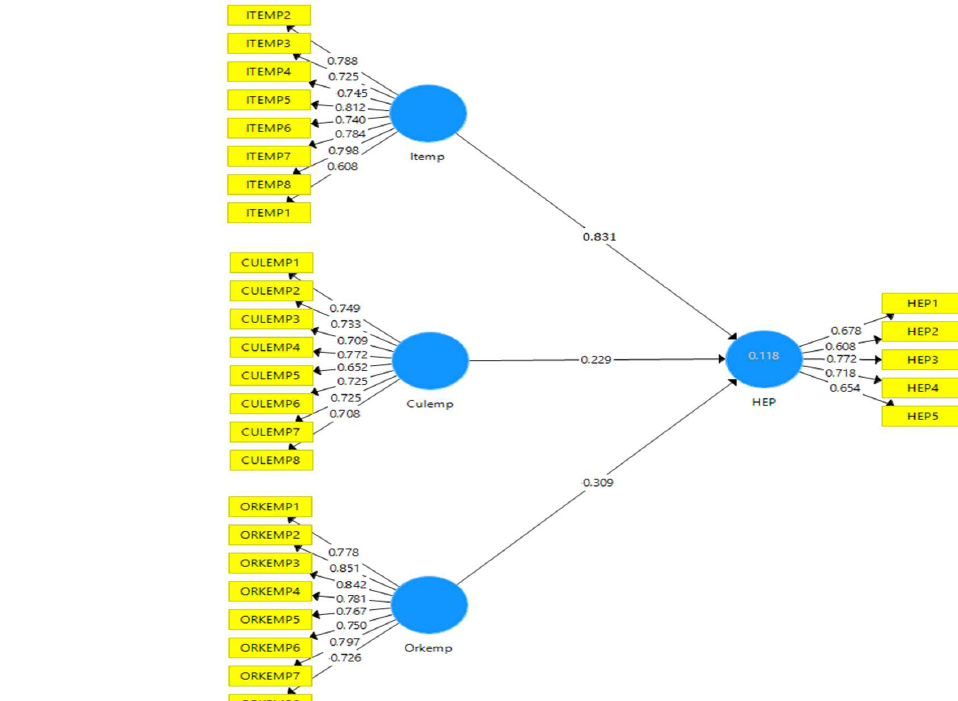
Fig. 3. Structural Model with path output (Human empowerment and higher education productivity) Source: